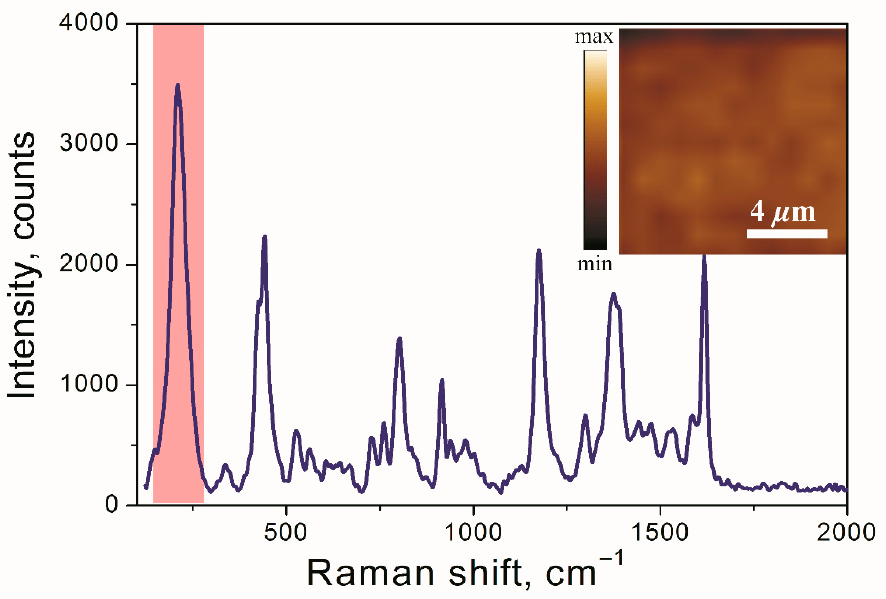
Figure 8. SERS spectra of CV with the concentration of 10 − 7 M adsorbed on ensembles of silver NPs. The shaded column marks the range used for the SERS mapping, which is shown in the insert.